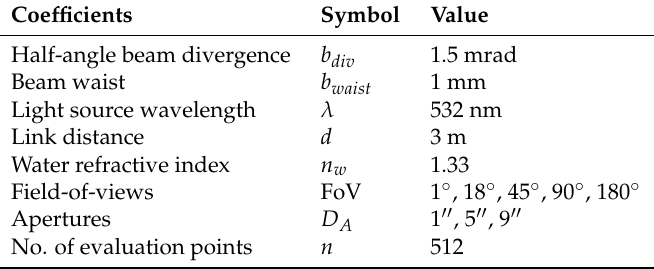
Table 3. Important parameters used for temporal dispersion characterization and MC-based channel